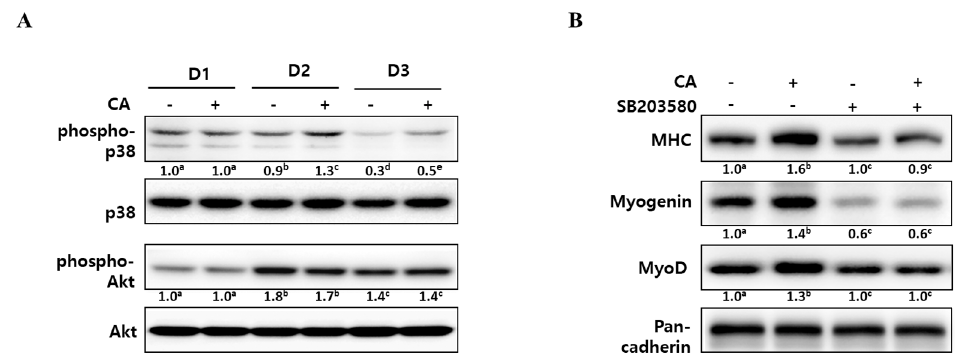
Figure 4. Effect of corylifol A on p38 MAPK activation during myogenesis. ( A ) C2C12 cells were treated with corylifol A (CA, 100 nM) during differentiation and subjected to Western blot analysis on differentiation day 1 (D1), 2 (D2) or 3 (D3). The levels of phospho-p38 and Akt were normalized against the respective total protein level. ( B ) C2C12 cells were pretreated with SB203580 (10 µM) prior to corylifol A and then differentiated in DM for 2 days. Cell lysates were subjected to Western blot analysis. Values are mean ( n = 3). The images are representative of three independent experiments with similar results. Means without a common superscript differ significantly ( p < 0.05).